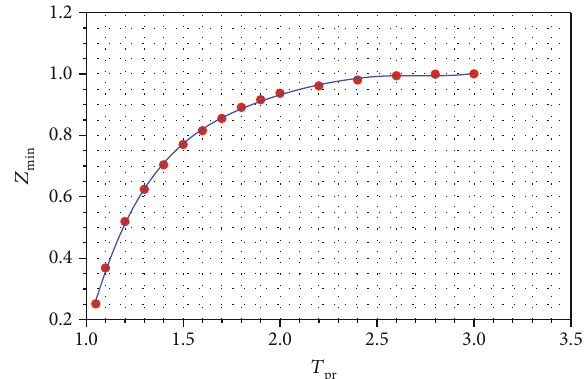
Figure 3: Minimum deviation factor at di ff erent pseudoreduced pressures.